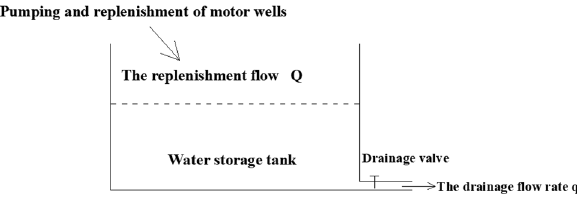
Figure 4. There is a drainage outlet and passage, and the drainage valve controls the drainage resistance.